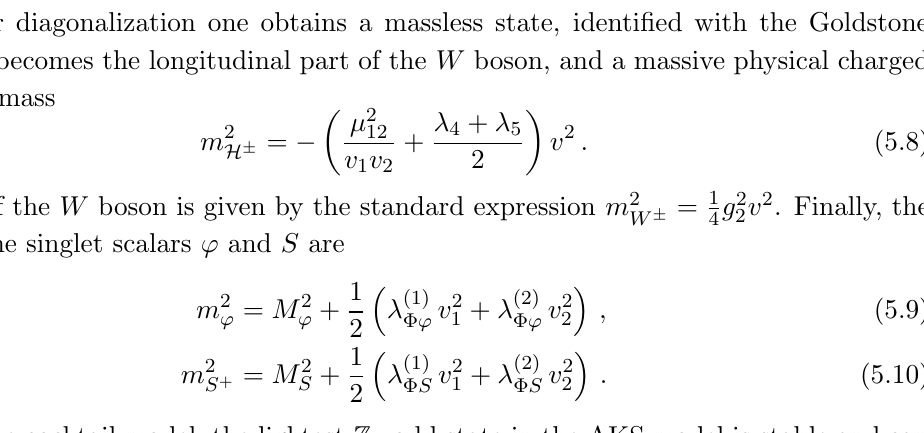
(cid:0) 1 ; 2 represent the singly charged H (cid:0) (cid:17) H (cid:8) (cid:9) (cid:8) (cid:0) ; (cid:8) (cid:0) states. 1 2